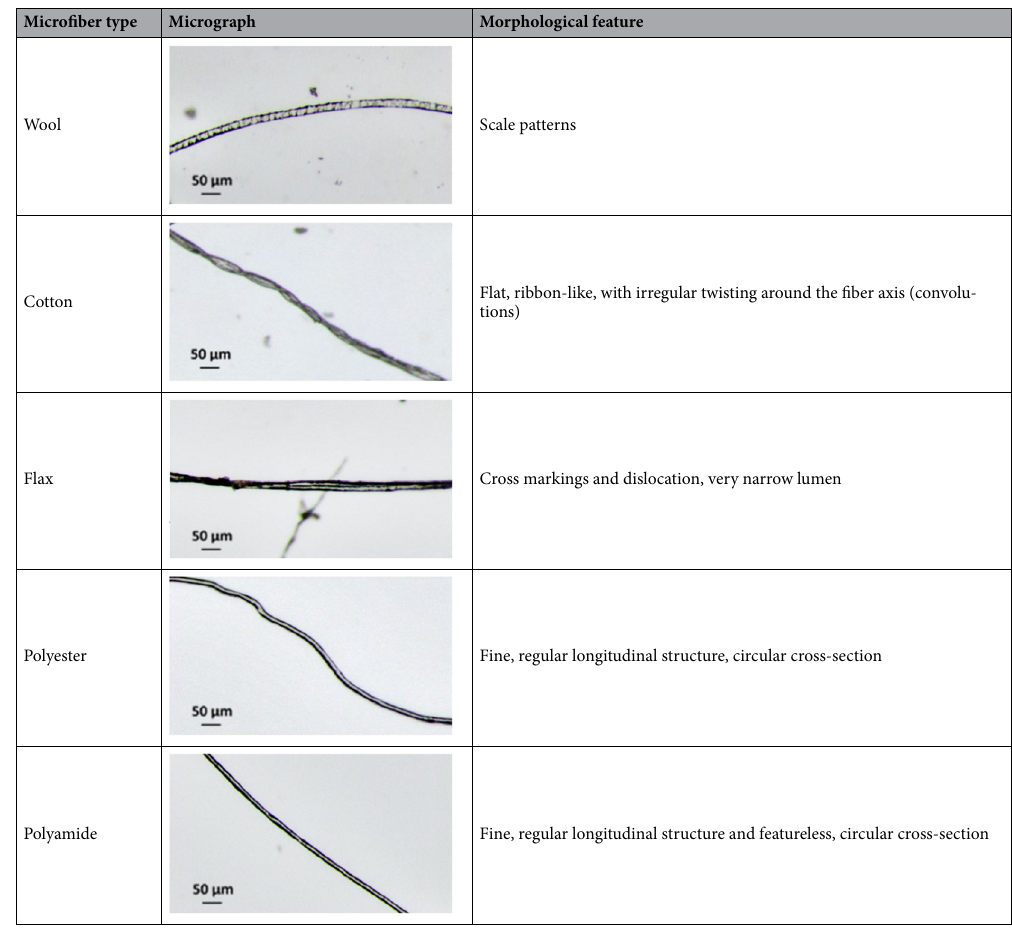
Table 1. Typical morphological features of natural and synthetic